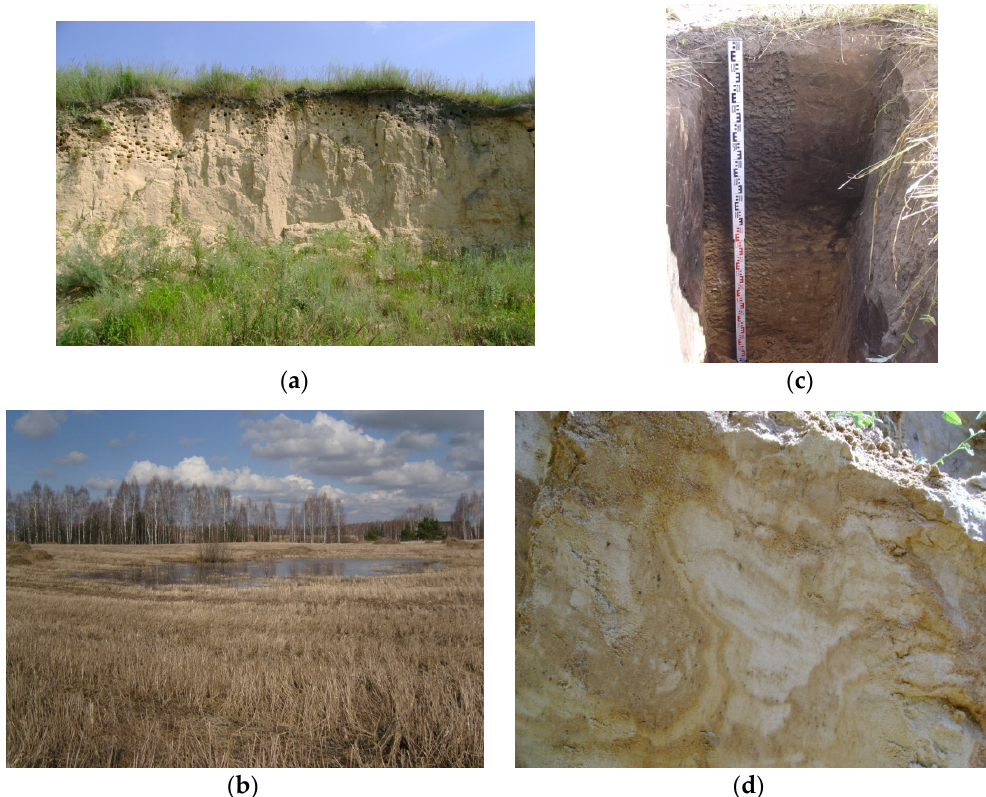
Figure 2. ( a ) Micro-depression in upper part of quarry; ( b ) micro-depression in landscape; ( c ) second humus horizon, micro-depression profile; ( d ) Cryoturbation within sandy deposits, Krasnoe outcrop.